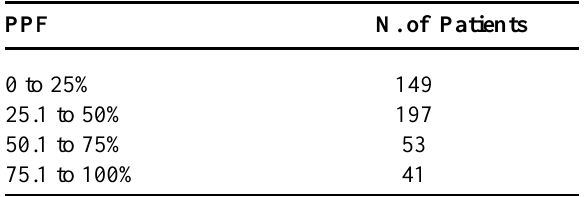
Table 3 – Patient distribution according to the percent- age of positive fragments (PPF) at pre-operative biopsy.